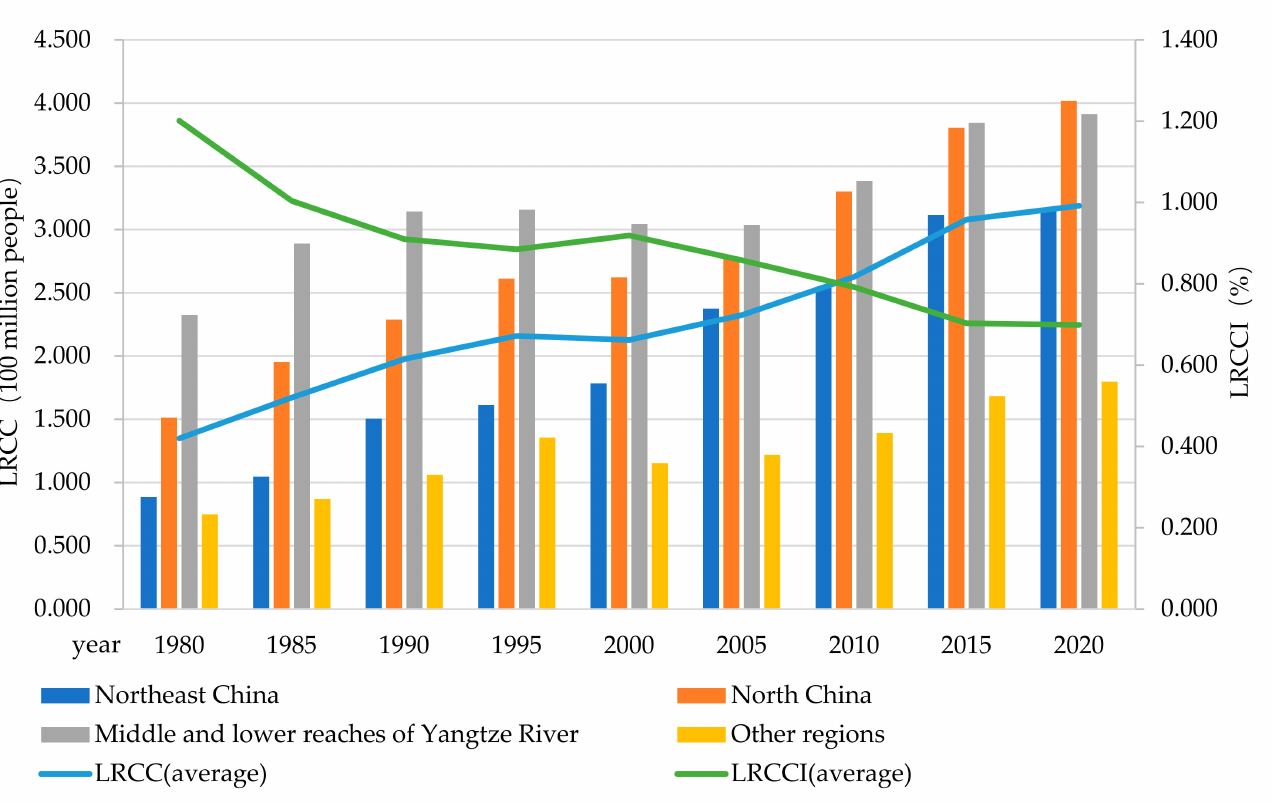
Figure 2. LRCC and LRCCI of the four regions of China’s major grain-producing